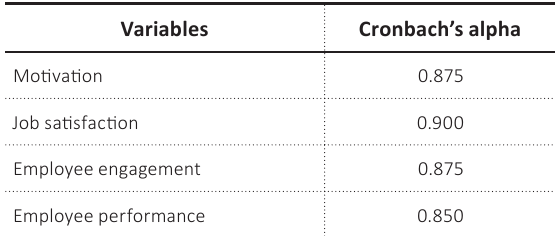
Table 5. Cronbach’s alpha